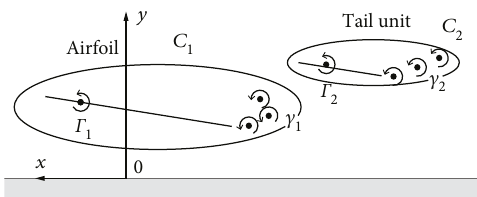
Figure 2: Sketch of the lifting system, the coordinate system, and contours C and C 1 2